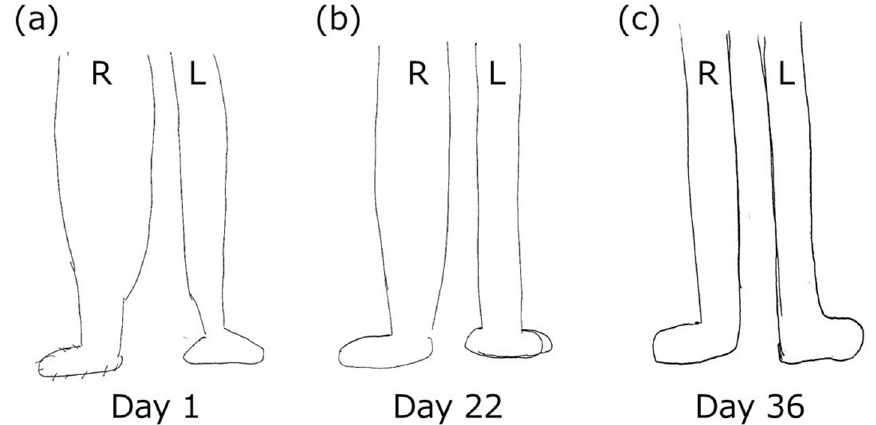
Figure 3. Line drawings of lower extremities in day 1 ( a ), day 22 ( b ), and day 36 ( c ). Table 1. Maximum widths and areas in the portrait drawn.